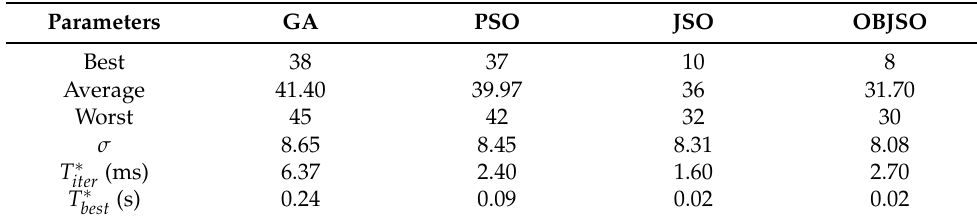
Table 7. A performance comparison in terms of